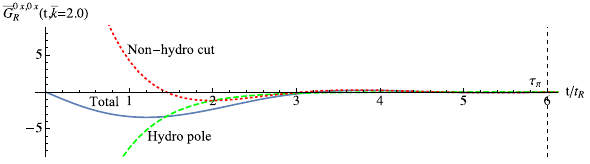
Fig. 13 Same as Fig. 11, but now for a larger momentum scale ¯ k = 2 for which the hydrodynamic pole does not dominate the time evolution on any